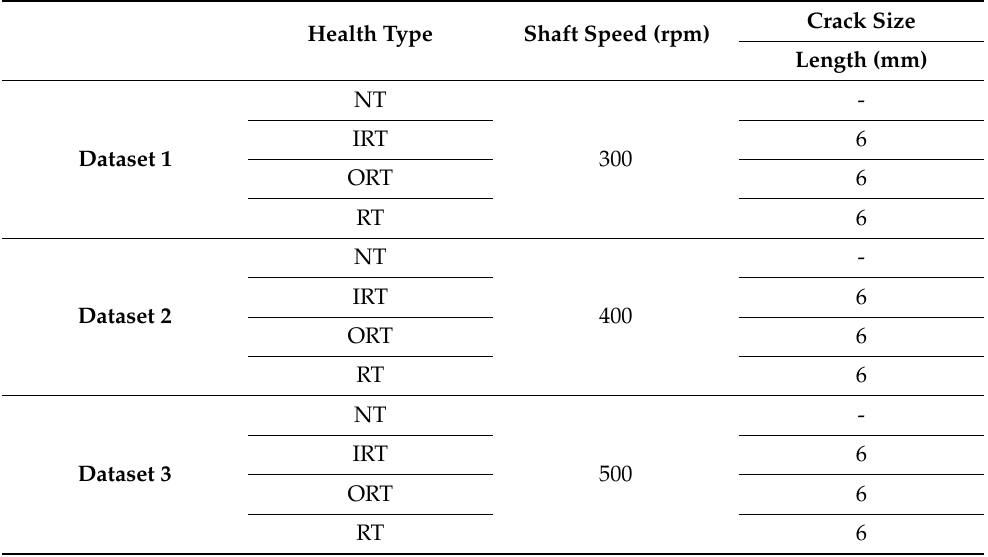
Table 1. Details about the working environment for case study 1.